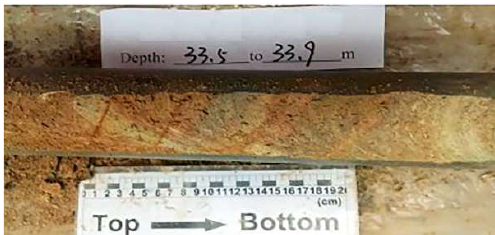
Figure 5. Borehole sample in CW gneiss layer.